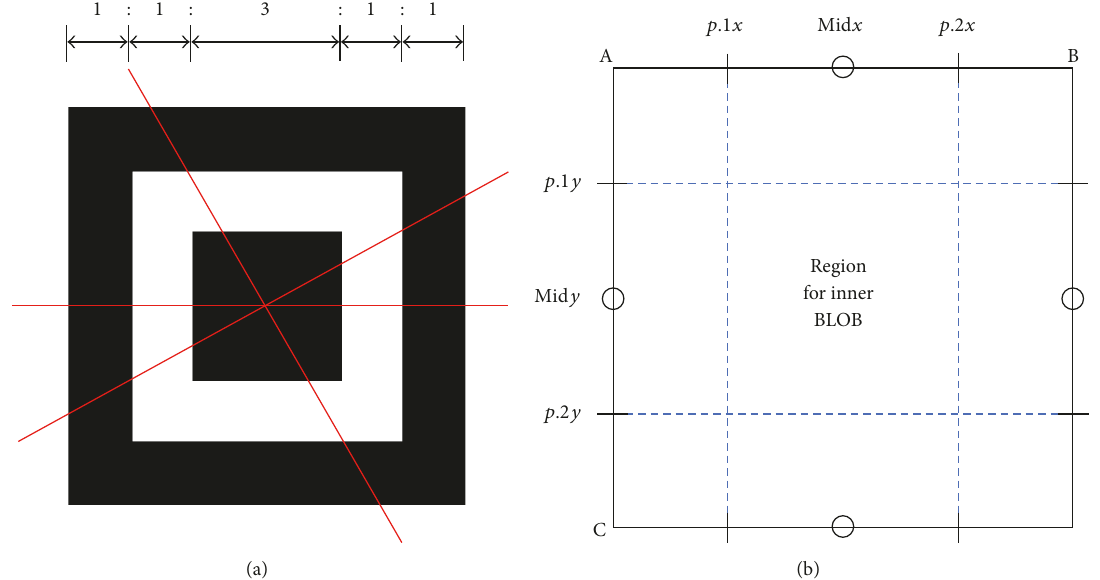
Figure 5: Considerations for selection of BLOB pairs similar to PDP into SPDP: (a) technique used in [7]; (b) technique of the proposed